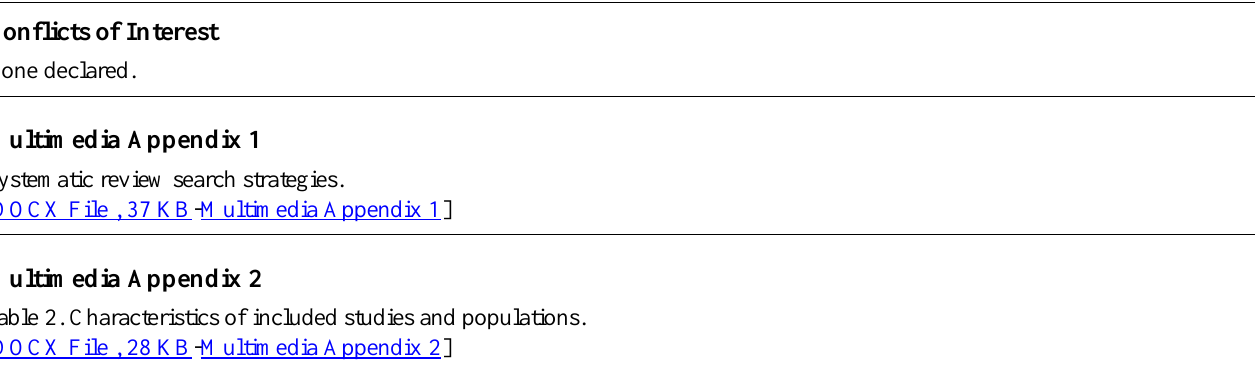
Table 2. Characteristics of included studies and